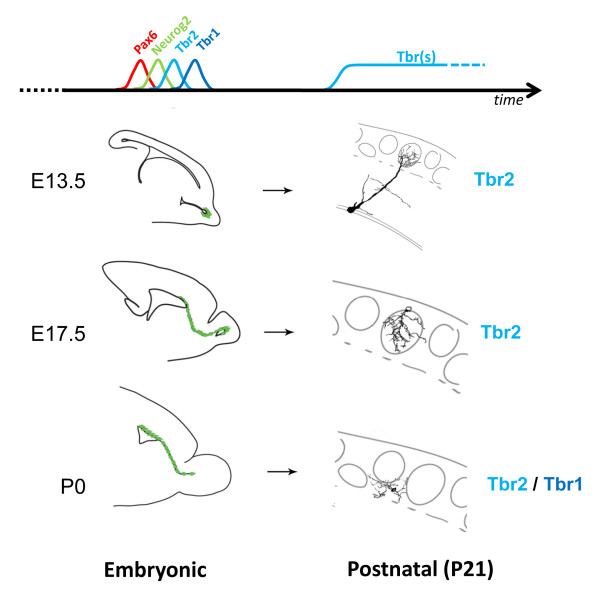
Schematic representation of results obtained in this study. The left-hand drawings represent the pattern of Neurog2 expression in the mouse OB, RMS and dorsal wall of the lateral ventricle at the developmental stages analyzed in this study (E13.5, E17.5 and P0). Note that at all stages progenitors sequentially and transiently express Pax6, Neurog2, Tbr2 and Tbr1. The right drawings are neurolucida reconstructions of mature neurons produced at these different developmental stages. Note the different morphologies. All neurons express Tbr2 independently of their date of birth, but only neurons generated at late developmental stages also express Tbr1.